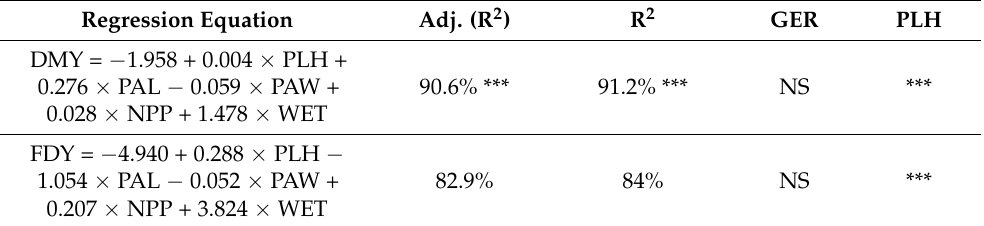
Table 4. Multiple linear regression equation of different sorghum yield traits on dry matter yield and fodder yield as affected by years, locations, and P-K levels during 2015 and